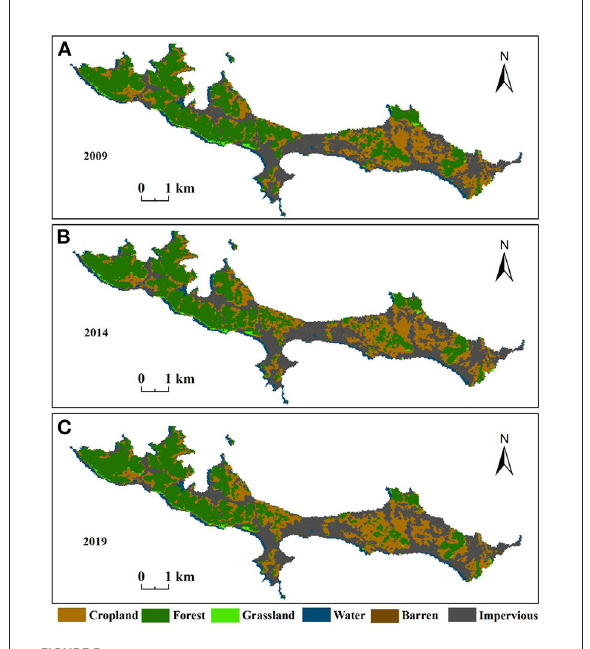
FIGURE5 (A–C) Shows the different land use in 2009, 2014, and 2019,